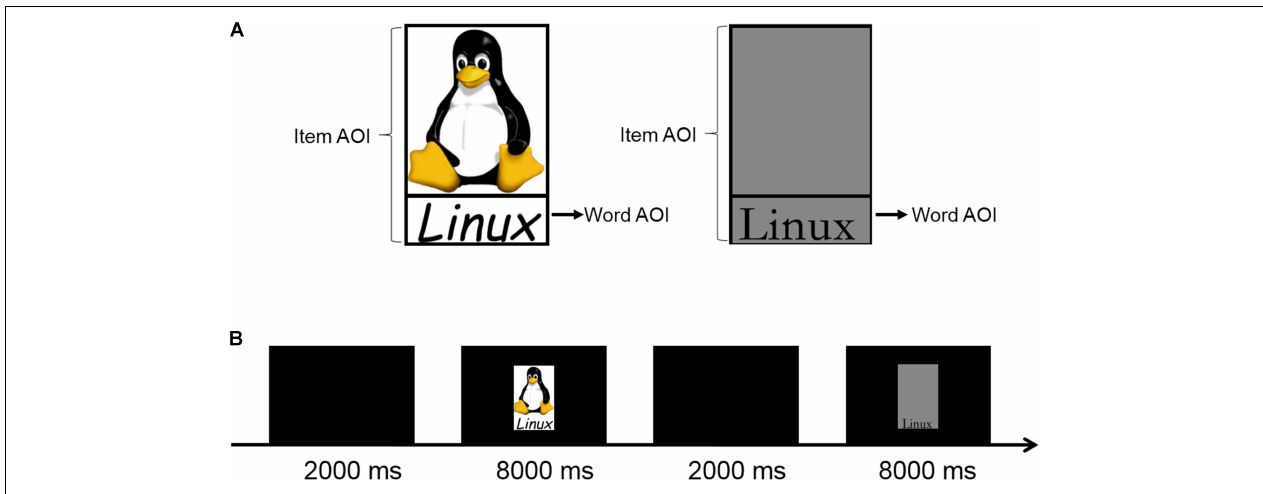
FIGURE 1 | (A) Sample environmental and standard prints, and their item- and word-AOIs. (B) Sequence of events in a mini-block of trials in the free viewing task. For copyright issues, the logos cannot be used in this illustration. Therefore, we use the Linux logo instead to illustrate the definition of word and item AOIs in environmental and standard prints. The Linux log (the penguin in the above illustration) was created with GIMP by Larry Ewing (lewing@isc.tamu.edu). The Linux logo now used in the illustration is for illustration purpose only; it was not used in our study. The Linux logo, is copyrighted to Larry Ewing, and can be used for any purpose, provided that the copyright holder is properly